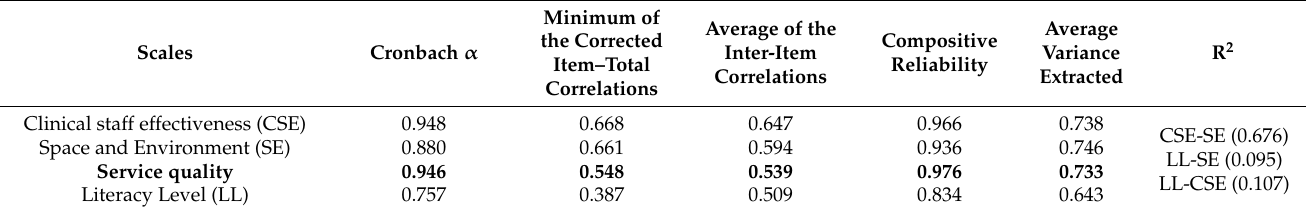
Table 5. Reliability and validity